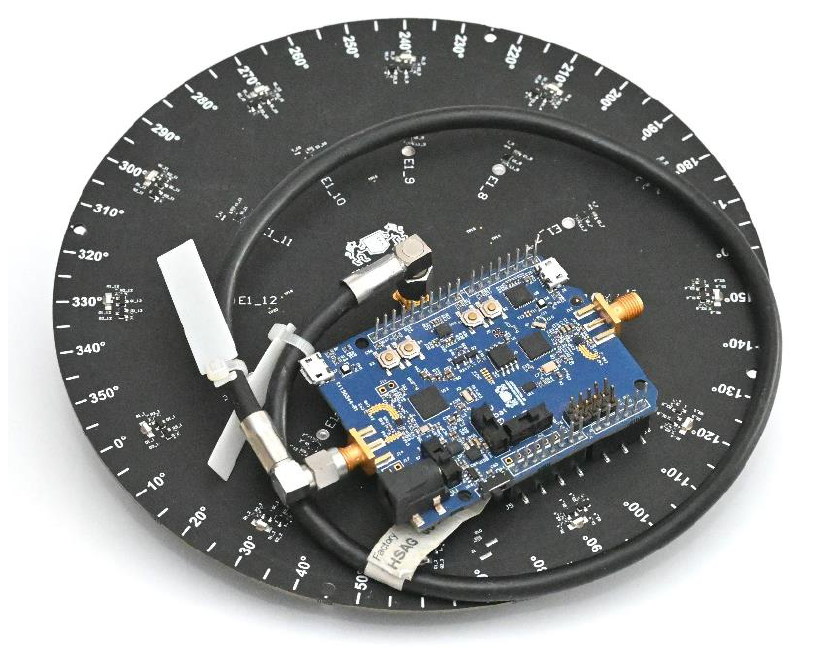
Figure 6. The ESPAR antenna connected to the custom-made nRF52840 wireless sensor network (WSN) board via Arduino Shield header pins. The WSN board’s radio frequency (RF) signal output is connected to the ESPAR antenna’s center element via a black SMA cable.